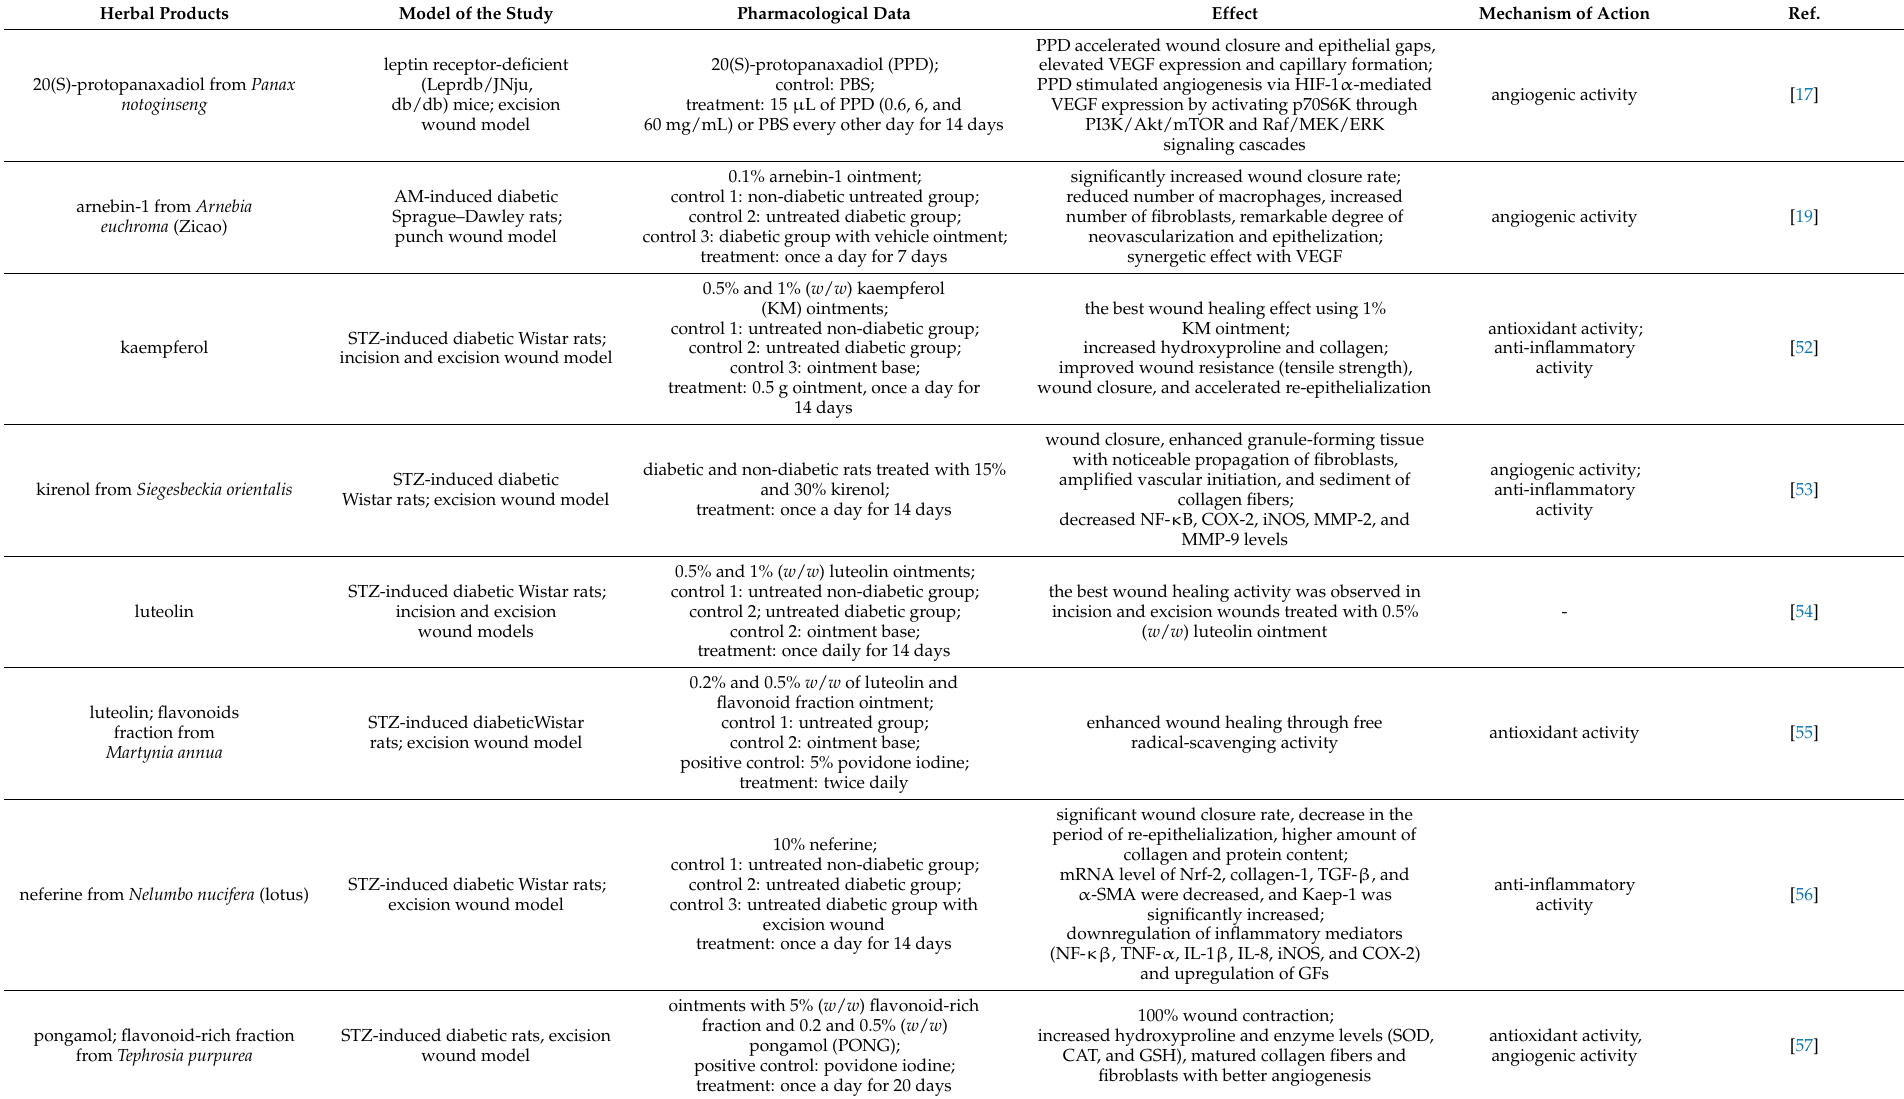
Table 2. Active constituents isolated from herbal products used for diabetic wound healing, animal-based